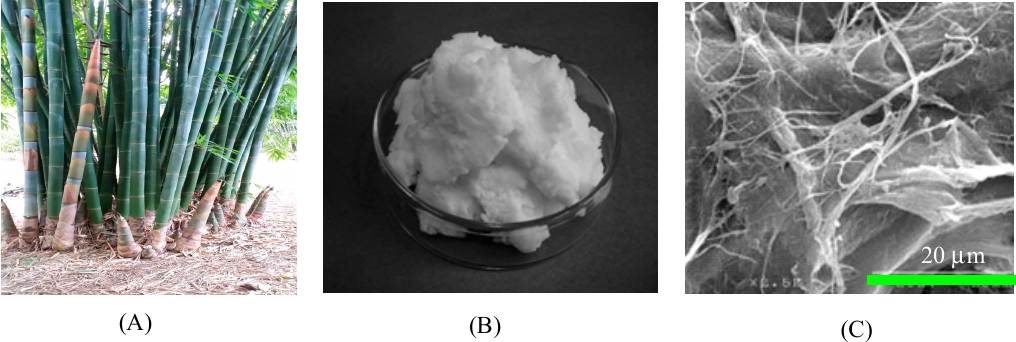
Figure 1. Picture of white bamboo ( A ), micron-size white bamboo fibrils (MWBFs) ( B ), and SEM image of MWBFs ( C ).